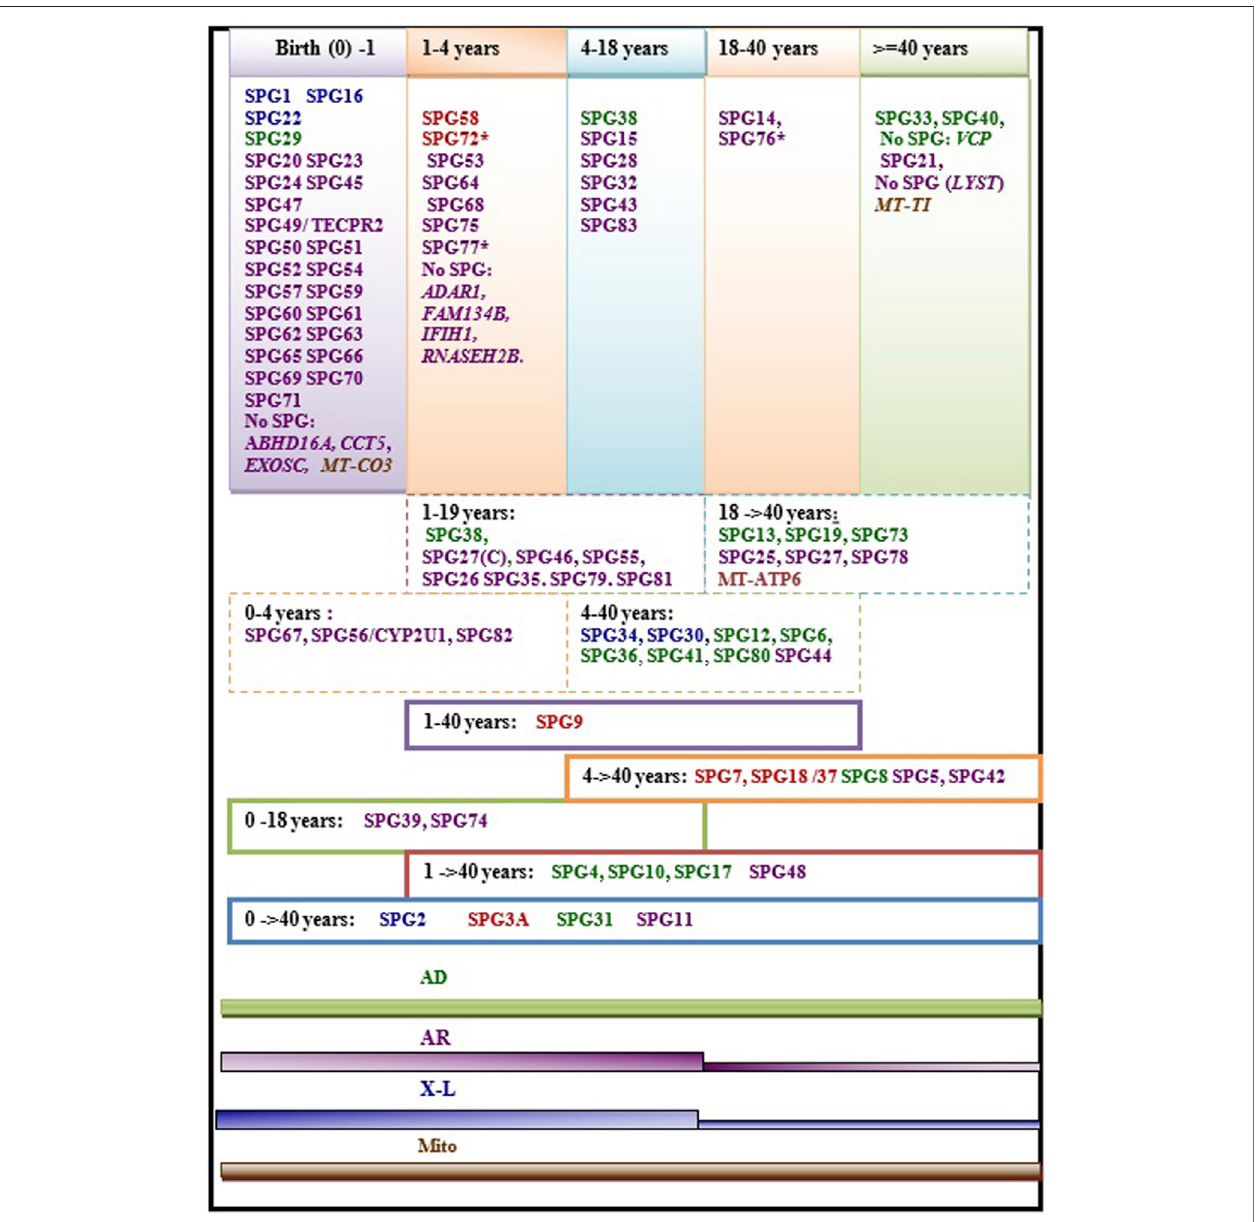
FIGURE 2 | Regrouping of the age at onset of various HSP subtypes. The asterisk (*) indicates few exceptions in the age at onset range: SPG76*[one case is congenital] SPG72* and SPG77* has an age at onset range between (1 – 5 years)], SPG27 stands for the pure form and SPG27C for the complex form of SPG27. Font color codes represent the modes of inheritance: AD HSP (green), AR HSP (violet), X-linked recessive (Blue), Mitochondrial (brown), and Mixed AR/AD inheritance (red).